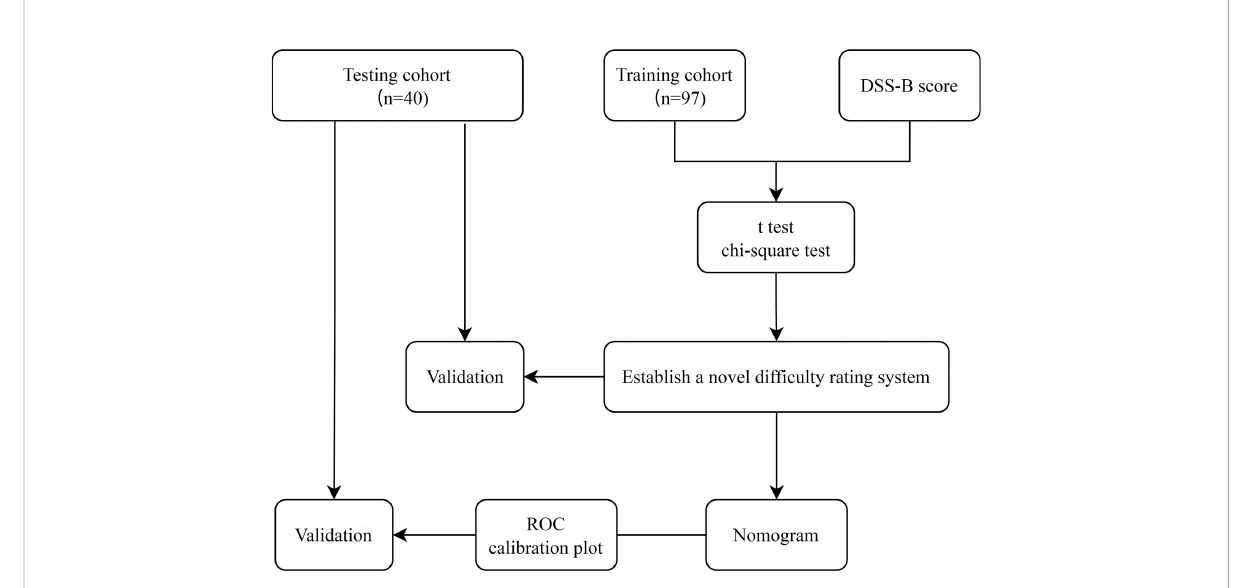
FIGURE 2 The fl owchart of our research. ROC, receiver operating